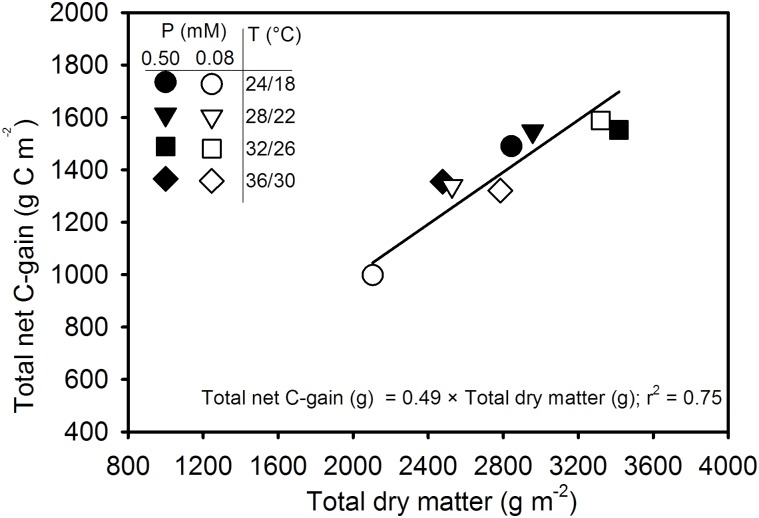
Carbon balance comparing the seasonal total net C-gain from canopy photosynthesis with the total aboveground dry matter produced across temperature (T, day/night) and phosphorus (P) treatments. Data represent an experimental unit for each treatment. The regression fit was significant as P ≤ 0.0001.